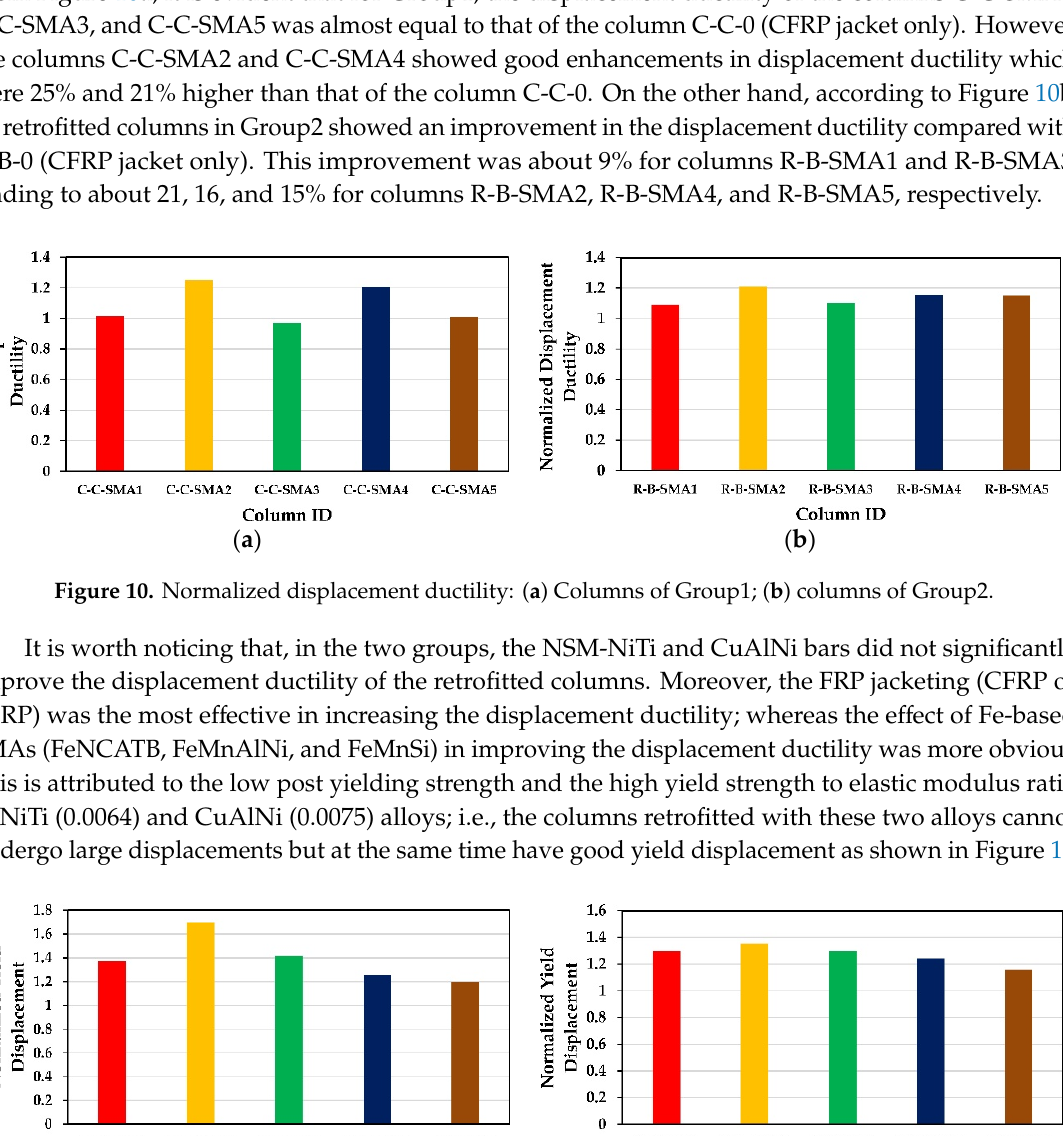
Figure 11. Normalized yield displacement: ( a ) Columns of Group1; ( b ) columns of Group2.